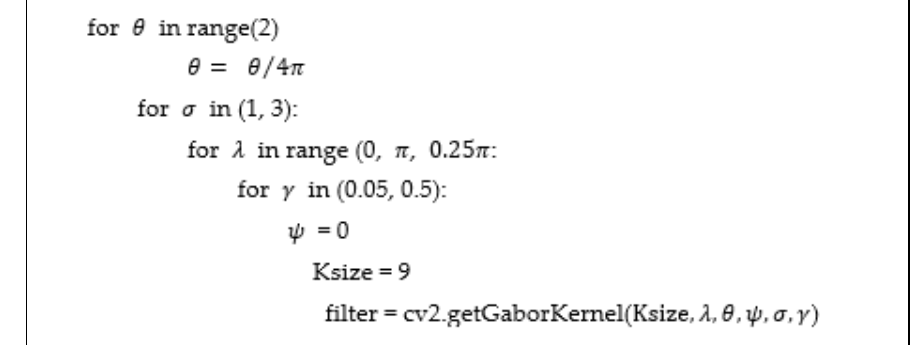
Figure 8. Parameters of Gabor filters.